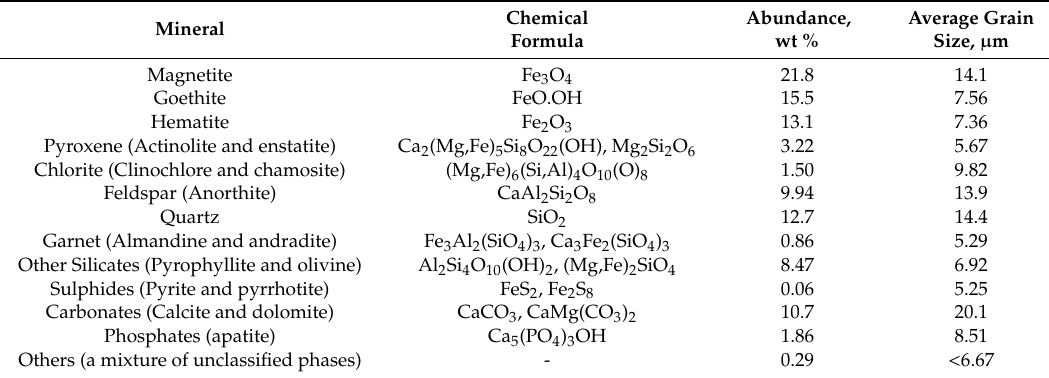
Table 2. Mineral phases, their abundance, and average grain size in the ore. Mineral